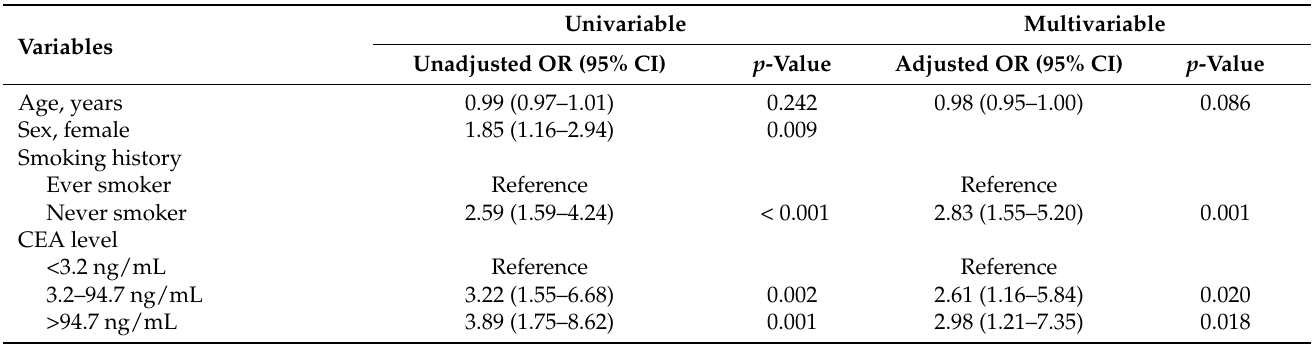
Table 2. Factors associated with a positive result of plasma EGFR mutation analysis (N =